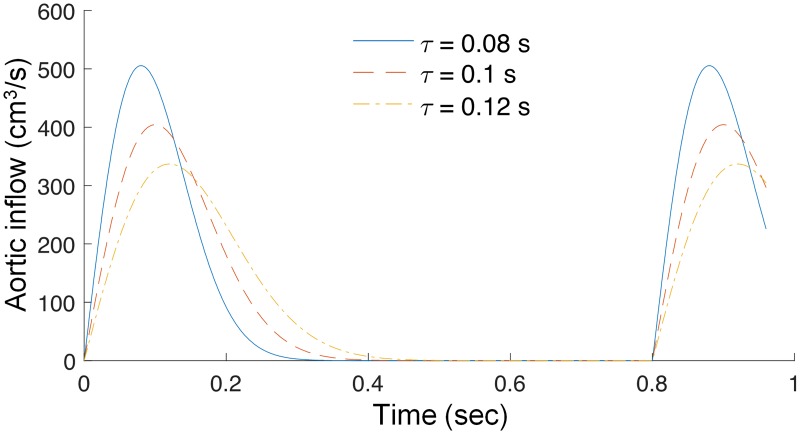
Assumed aortic inflow.Dependence of the heart ejection profile on parameter τ (τ = 0.08, 0.1 and 0.12 seconds) for 5 L/min cardiac output and heart rate of 75 beats/min, see Eq (6).